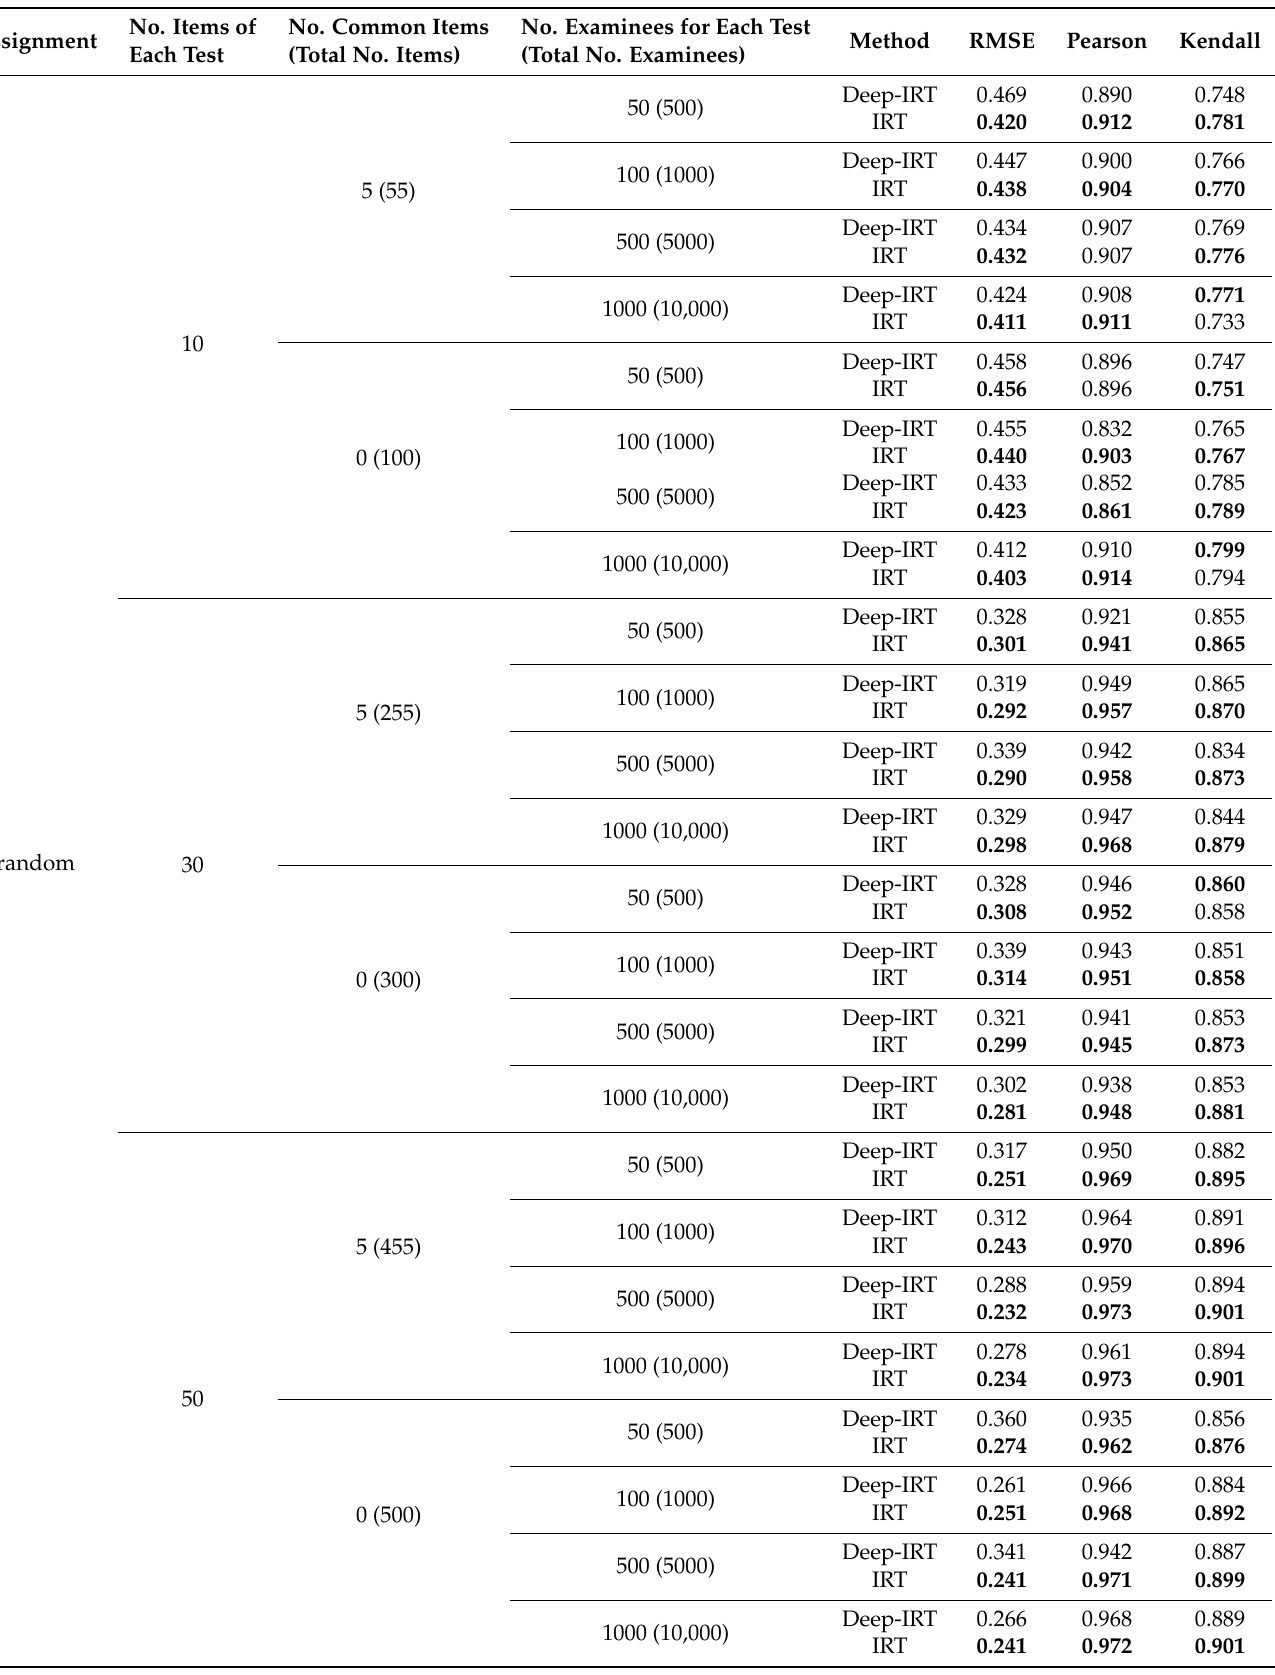
Table 2. Parameter estimation